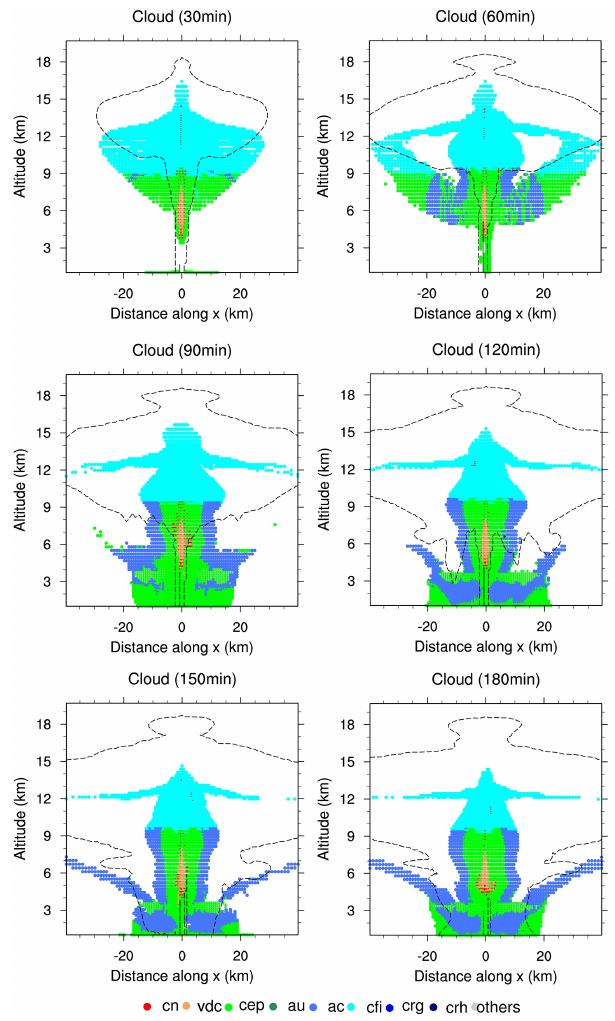
Figure 17. The pie charts summarize the vertical cross sections of the rate of change of main microphysical processes contributing to cloud water content. Each pie chart shows the averaged contribu- tion over the past 30min. Colors within each pie chart reflect the percentage of processes in each grid. The black dashed line is the 0.1µgkg − 1 isoline of the interstitial aerosol, indicating the shape of smoke plume. The meaning of the abbreviations is the same as in Fig. 16. Warm colors denote the sources, while cold colors denote the